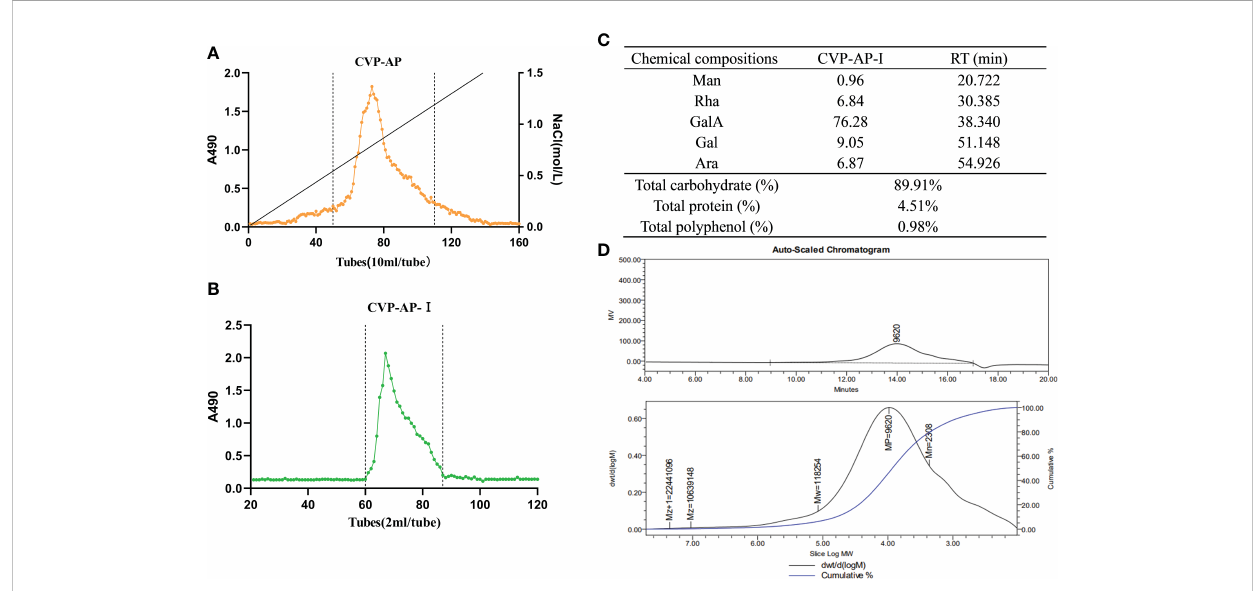
FIGURE 2 Isolation, chemical composition, monosaccharide composition and average-molecular weight of CVSS polysaccharides. (A) The elution curve of CVP-AP on DEAE anion exchange chromatography. A single component is obtained. (B) CVP-AP-I elution pro fi le was obtained after gel fi ltration puri fi cation. (C) The chemical compositions of CVP-AP-I including monosaccharide composition (mol %), total carbohydrate (%), protein content (%), polyphenol content (%). (D) The molecular weight determination of CVSS polysaccharide by gel permeation